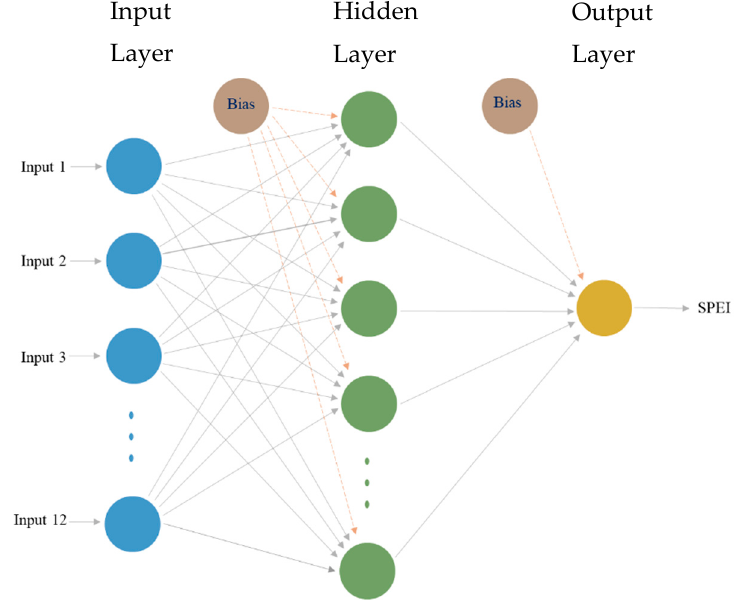
Figure 4. Artificial neural network general architecture.